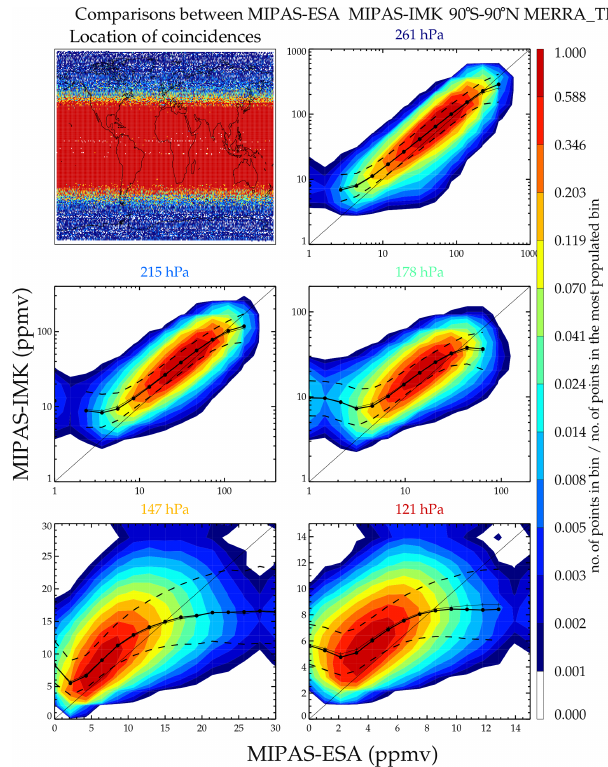
Figure 19. Same as Fig. 17 but comparing MIPAS-ESA and MIPAS-IMK. The coincidences cover a period from July 2002 to April